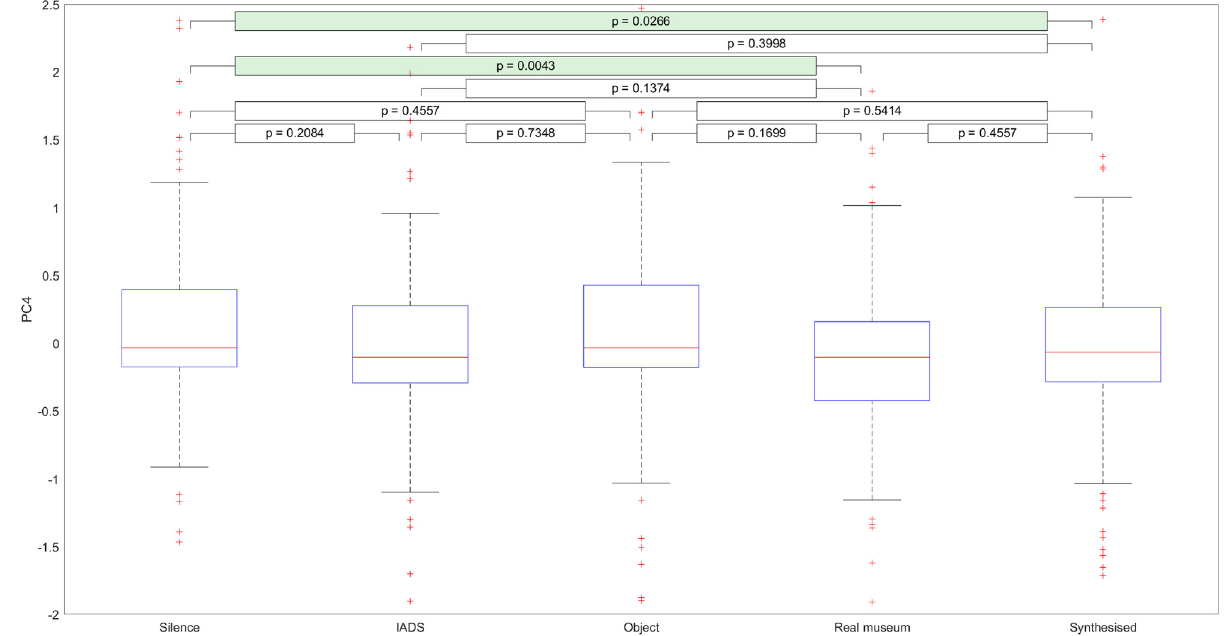
Fig 6. Distribution of PC4 across different types of